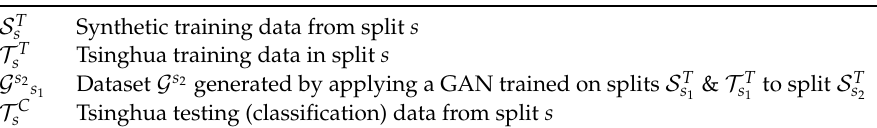
Table 1. Basic notation for data subsets.